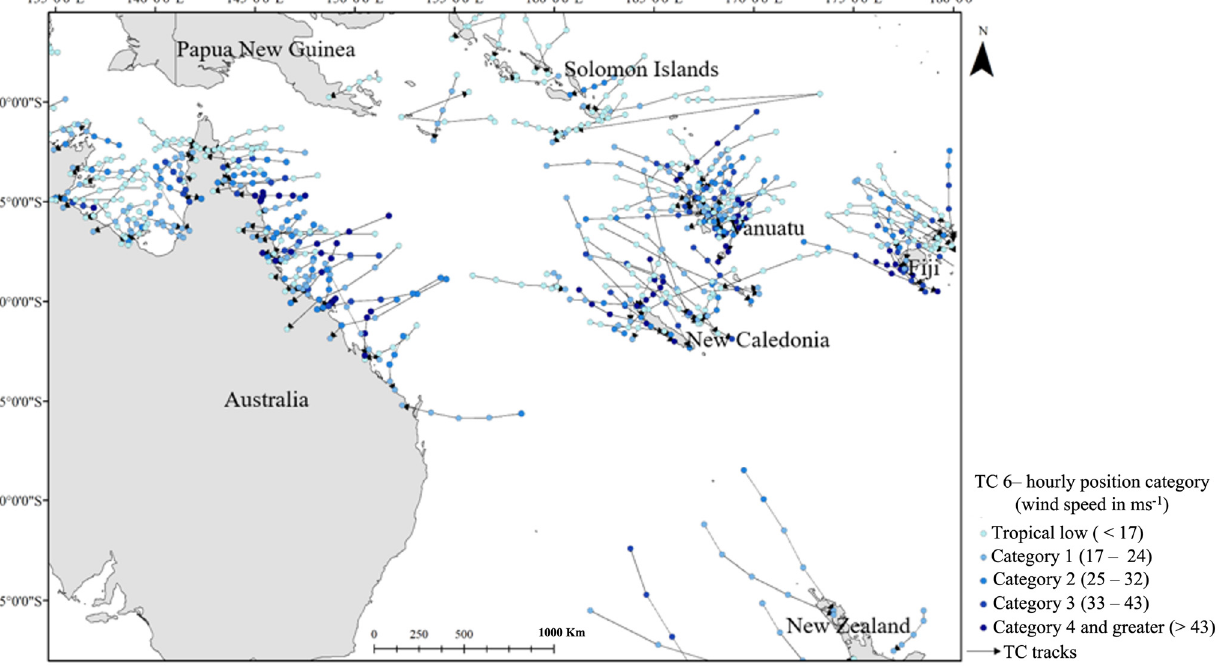
Figure 3. Tracks of TCs during the final 24 h before making their first landfall. Each track ends with the first observation after landfall. Black arrows are placed at the first observation point after making landfall. Tracks are colored based on the BoM Australia intensity scale. Table 3. Correlation matrix shows p -values between variables at 24 h before SWPO mainland landfall. Significant relationships at 0.05 level are shown in